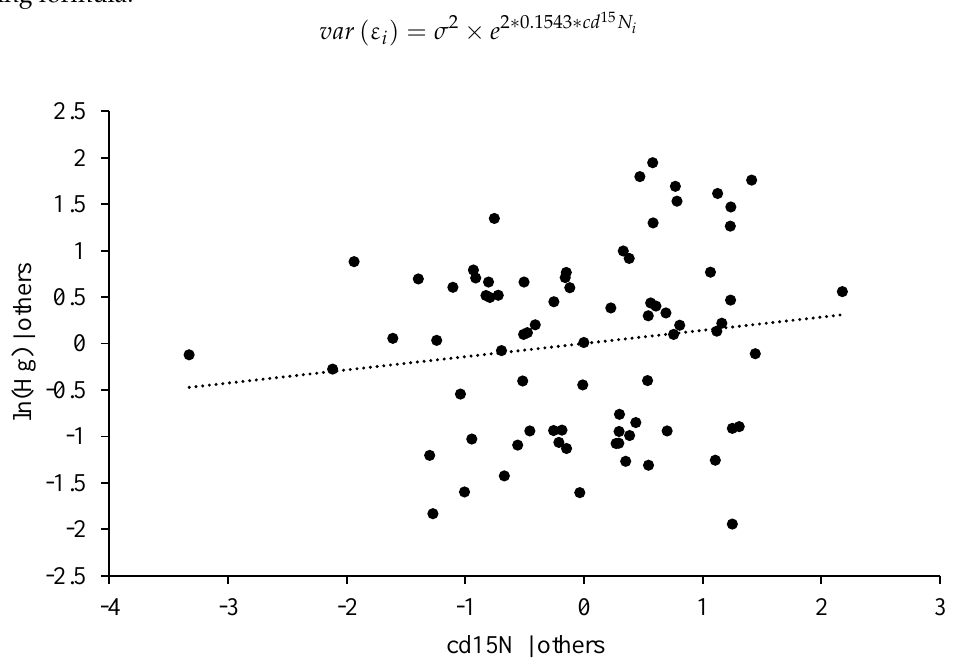
Figure 8. Partial linear regression between centered δ 15 N and logarithmically transformed Tot-Hg in A. charr. This regression was not significant, however, it was included due to heterogeneous residuals of the multiple linear regression model for Tot-Hg in A. charr.